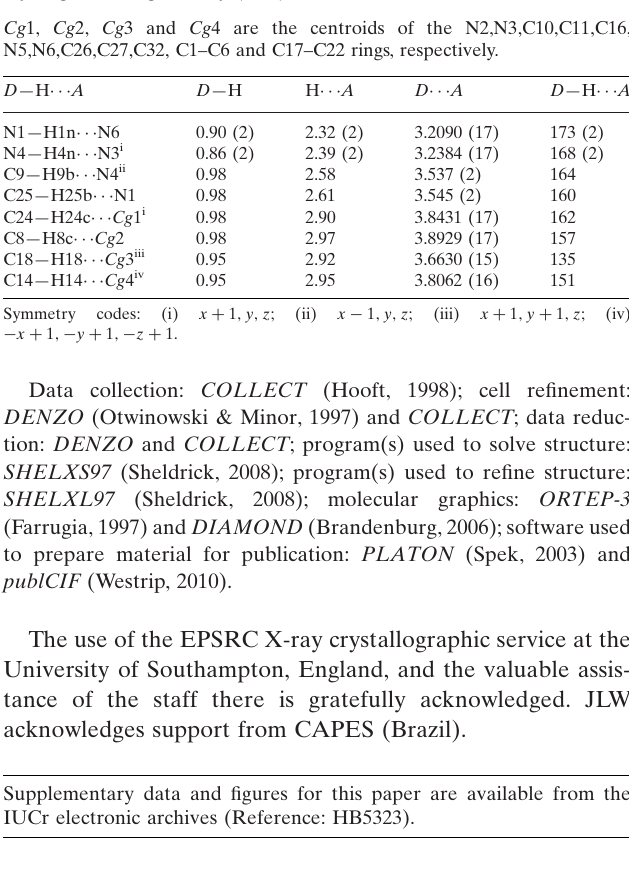
Hydrogen-bond geometry (A˚ , (cid:2)